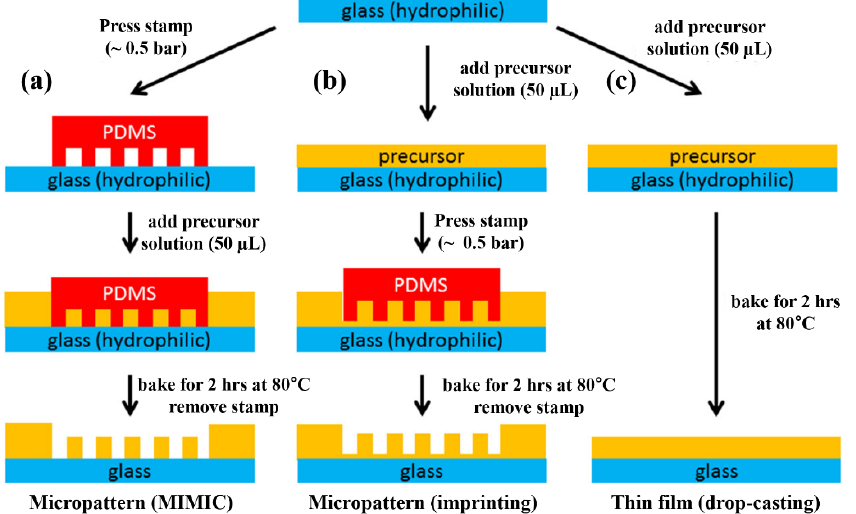
Figure 8. Schematic illustrations of two ways for micropatterning methods and drop-casting method for films as a reference: ( a ) MIMC method, ( b ) imprinting lithography method, and ( c ) drop-casting method. Reproduced with permission [66]. Copyright 2018, American Chemical Society.